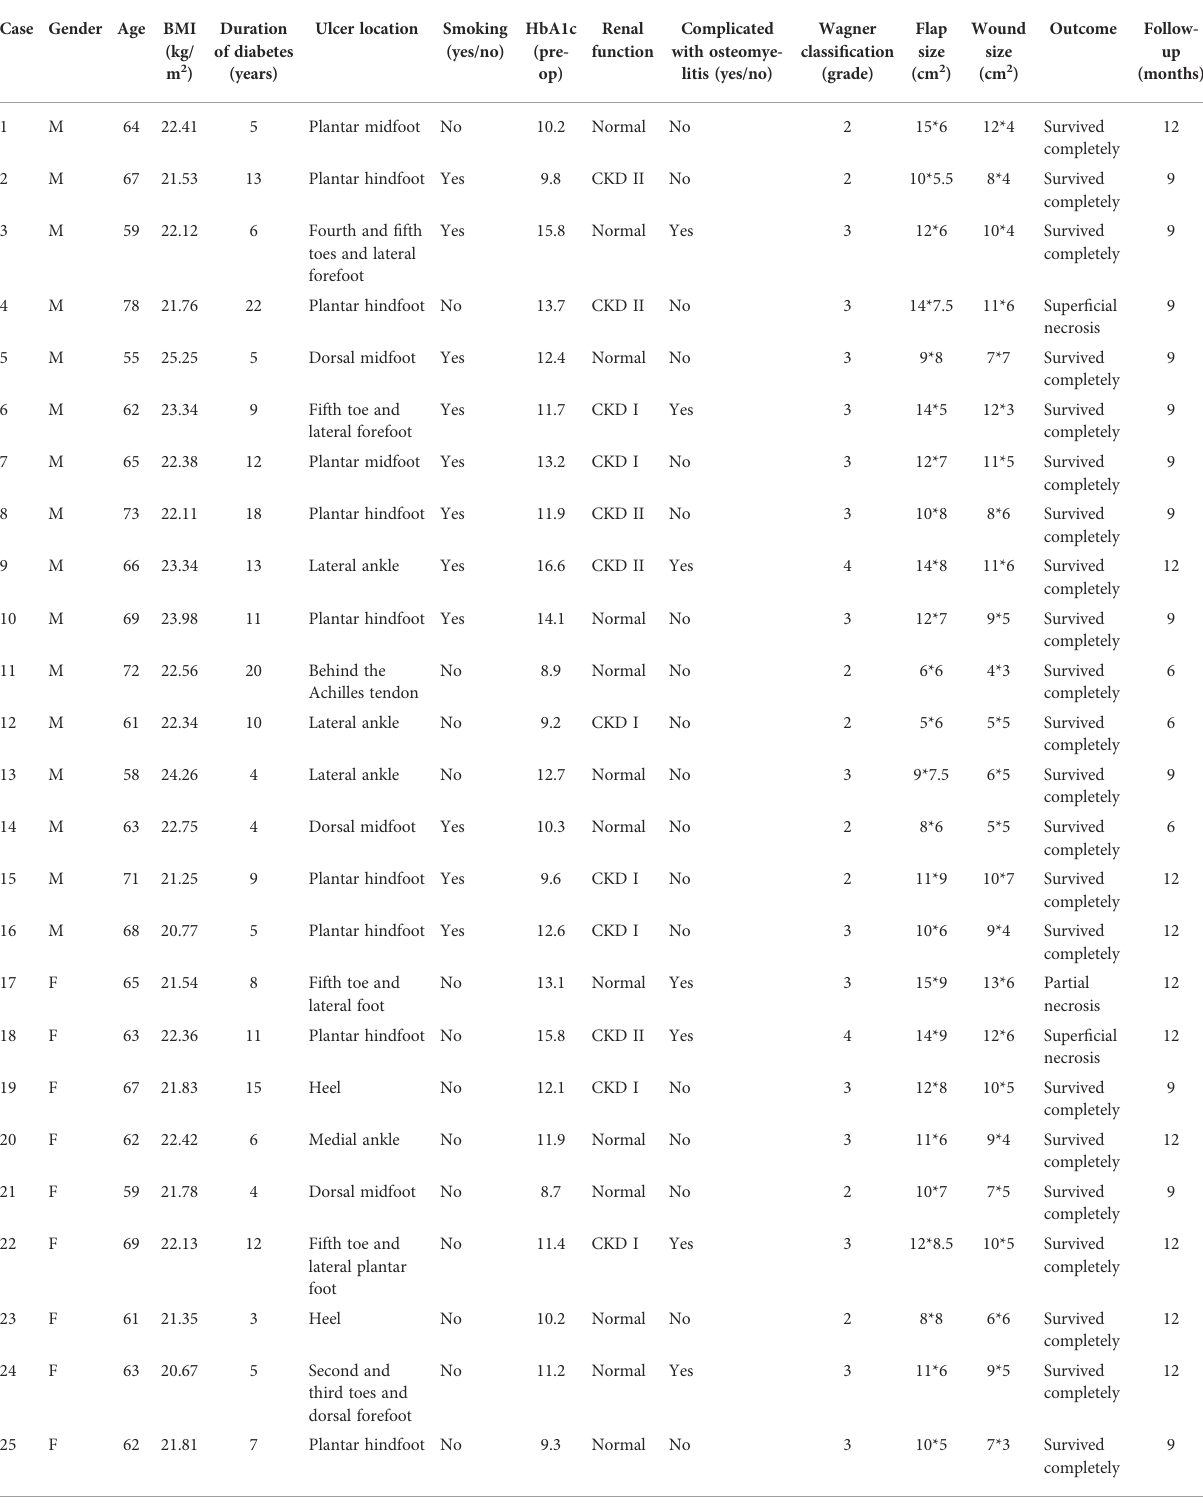
TABLE 1 Summary of the patients receiving distally based sural neurocutaneous fl aps for foot and ankle reconstruction. Case Gender Age BMI